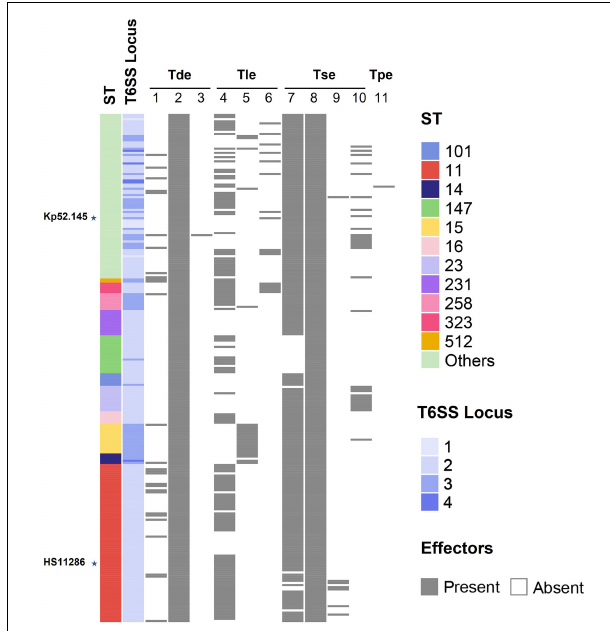
FIGURE 5 | Schematic representation of the relationship between ST type and T6SS effectors. Each color represents an isolate of a different ST type. The number of T6SS clusters (1–4) is shown in a blue gradient. The presence and absence of effector proteins are indicated by black and white rectangles, respectively. The labeled stars indicate the listed